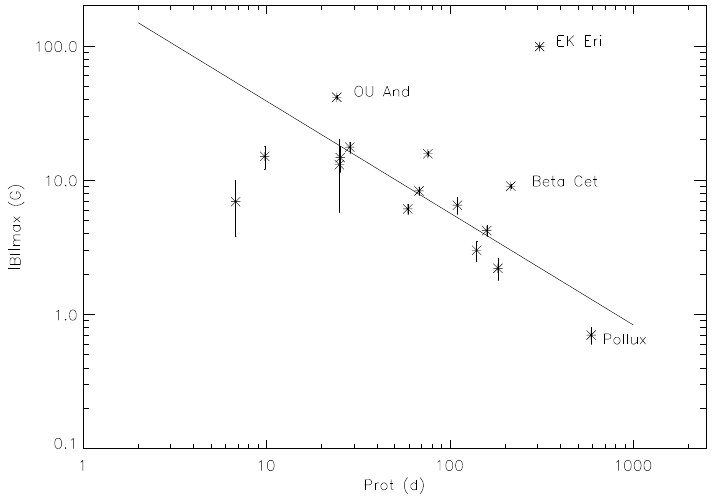
Figure 3. Magnetic field measurements of cool giants of Aurière et al., (2015) [10] over rotation periods—with courtesy of the